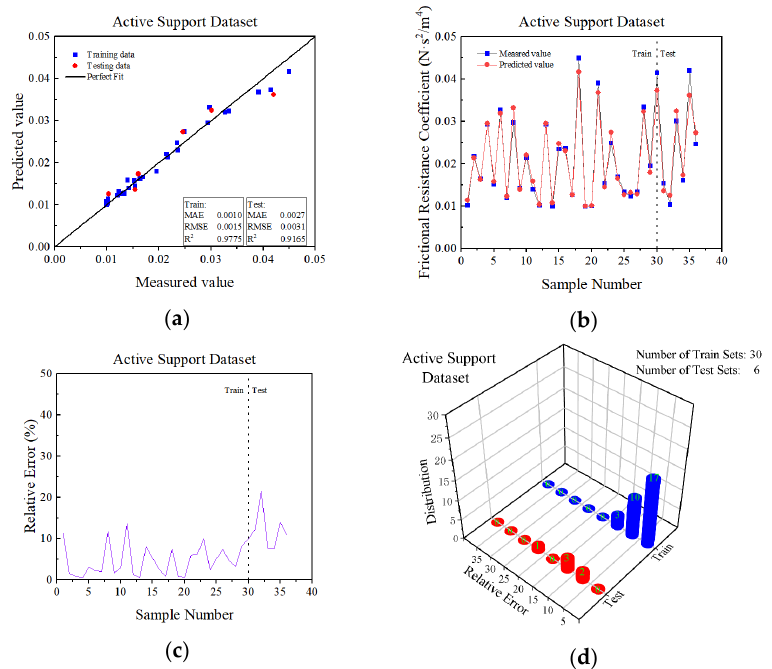
Figure 8. The passive support RF model prediction results. ( a ) Correlation evaluation of the meas- ured and predicted values of α; ( b ) curves of the measured and predicted values of the samples; ( c ) sample prediction error curve; ( d ) sample error frequency distribution.